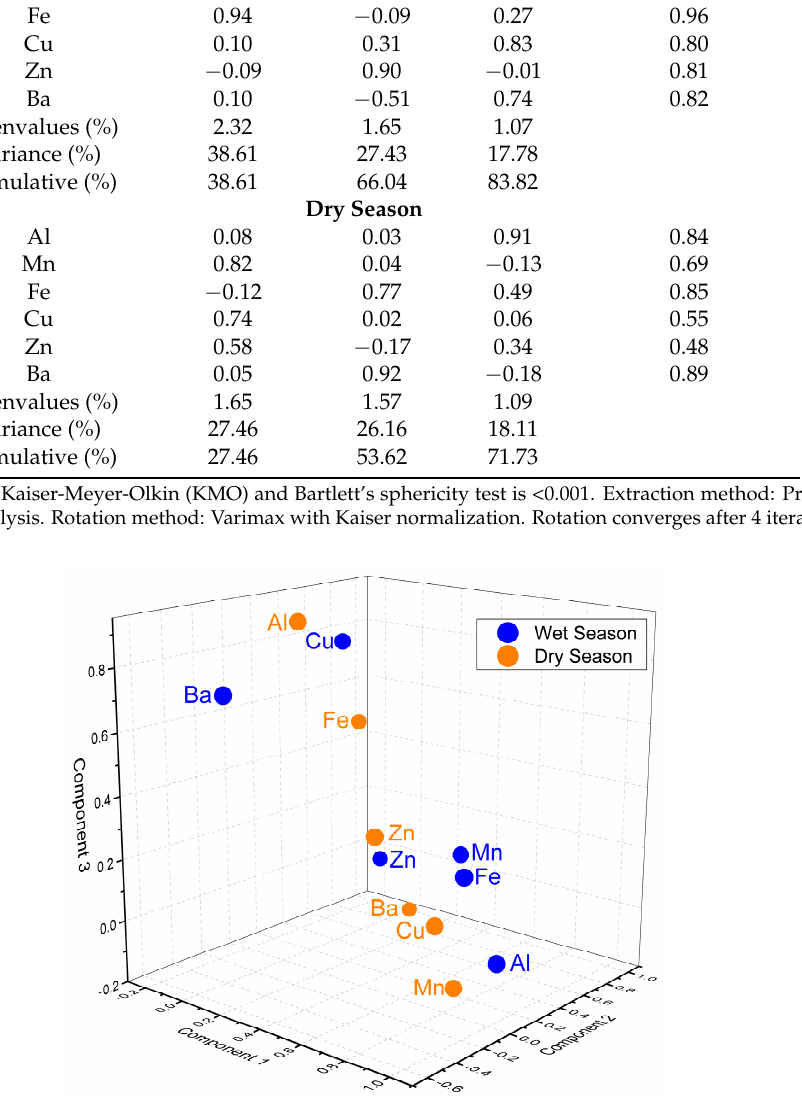
Figure 6. Water quality index ( WQI) values of water in the Mun River. 3.3.2. Hazard Quotient and Hazard Index The HI values (= Σ HQs) for dissolved heavy metals are listed in Table 6. The HQ for each element by ingestion and dermal pathways for adults and children are presented in Supplementary Materials (Table S3). Compared to adults, the higher HQ ingestion and HQ dermal values for children suggested that children are more sensitive when exposed to dissolved heavy metals in water. For both adults and children, the HQ ingestion and HQ dermal values for Al, Mn, Fe, Cu, Zn, and Ba in both seasons were smaller than 1, indicating no health effects on the human body and potential carcinogenic concern via daily